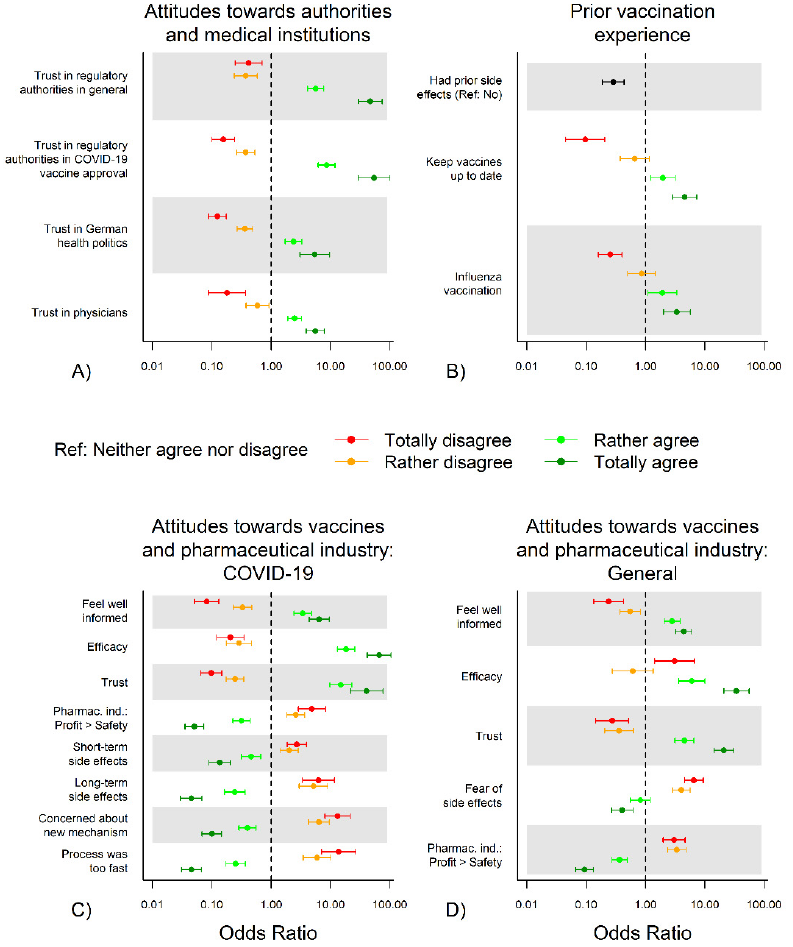
Figure 5. Attitudes toward and experiences with vaccinations. Attitudes towards authorities and medical institutions ( A ), prior vaccination experience ( B ), attitudes towards COVID-19-specific vaccines and the related parts of the pharmaceutical industry ( C ) and attitudes generally towards vaccines and the pharmaceutical industry ( D ). Abbreviations: Ref, reference; d., day; ICU, intensive care unit; incl., including; COVID-19, coronavirus disease 2019; Pharmac. ind., pharmaceutical industry. Numerical values of odds ratios with corresponding 95% confidence intervals are presented in Table